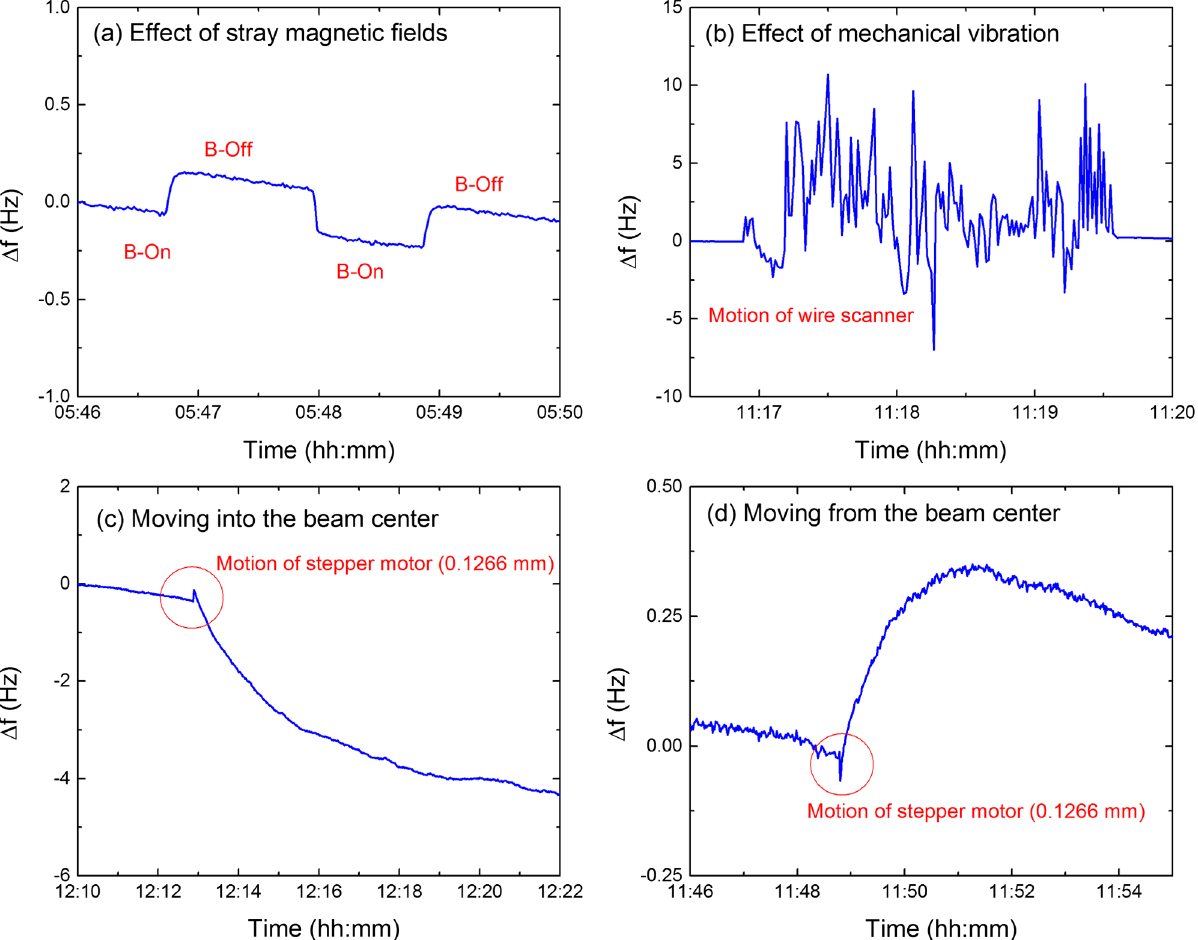
FIG. 11. Characteristics of the LA-VWM during the beam test at the HINS facility.